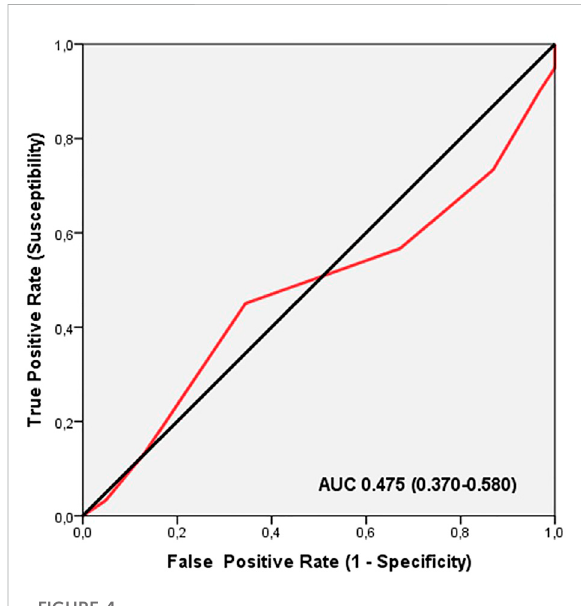
FIGURE 4 Receiver operating characteristic curve (ROC) summarizing theabilityofthetotalgenotypescore(TGS)todistinguishpotential match injured players from training injured players in muscle performance pro fi le, AUC, area under the curve.